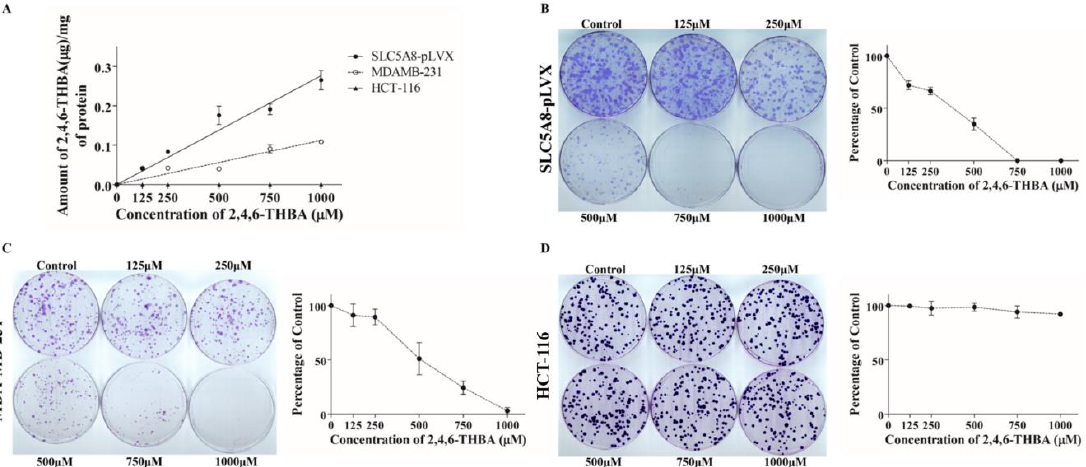
Figure 7. ( A ) HPLC analysis showing uptake of 2,4,6-THBA after 72 h in SLC5A8-pLVX, MDA-MB-231 and HCT-116 cells. ( B,C,D ) effect of 2,4,6-THBA (14 – 21 days) on colony formation in SLC5A8-pLVX, MDA-MB-231 and HCT-116 cells respectively. Quantification of the data is shown beside the crystal violet stained image of the